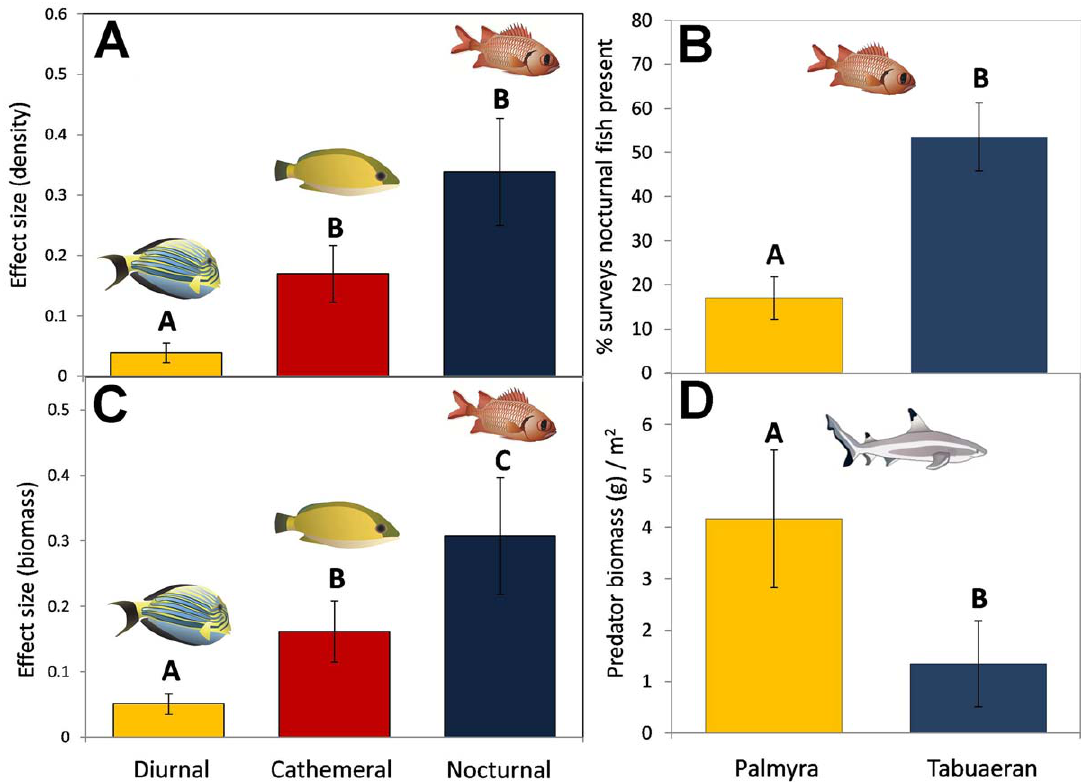
Figure 1. Effect size plots representing differences in the density (A) and biomass (C) of nocturnal, diurnal, and cathemeral prey fish on reefs at predator-depleted Tabuaeran Atoll relative to predator-heavy Palmyra Atoll. Positive values represent increases at Tabuaeran. Percentage of surveys (B) in which nocturnal prey fish were sighted at Palmyra and Tabuaeran. Comparisons of the biomass of all large ( $ 10 kg) diurnal and cathemeral piscivorous predators (D) at both atolls. All values are mean, 6 1 SE. Surveys marked with the same letters in each species grouping are not significantly different (after post-hoc correction).